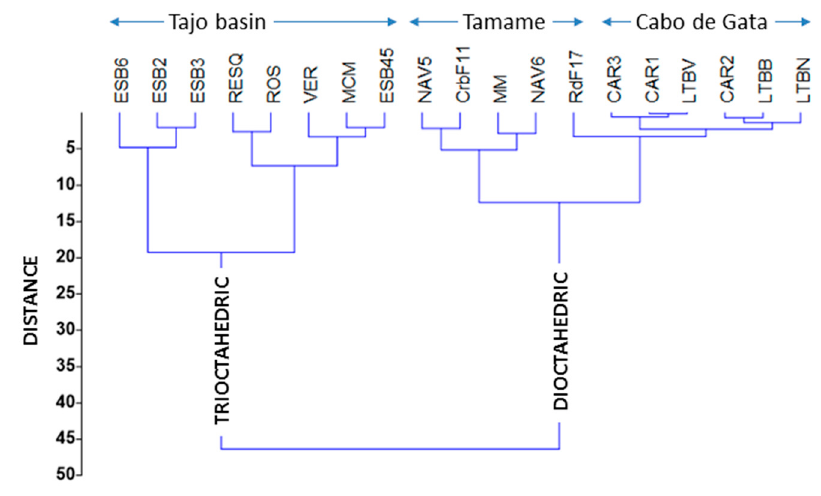
Figure 10. Hierarchical cluster obtained by Ward´s method considering the contents of the three main oxides (SiO 2 , Al 2 O 3 , and MgO).